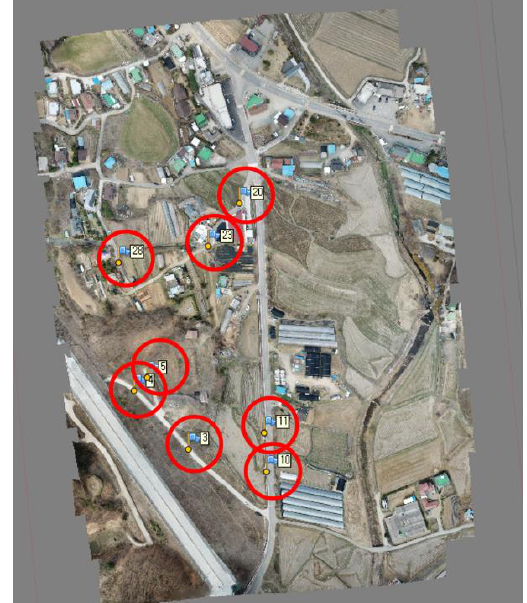
Figure 5. The generated point cloud and distribution of GCPs